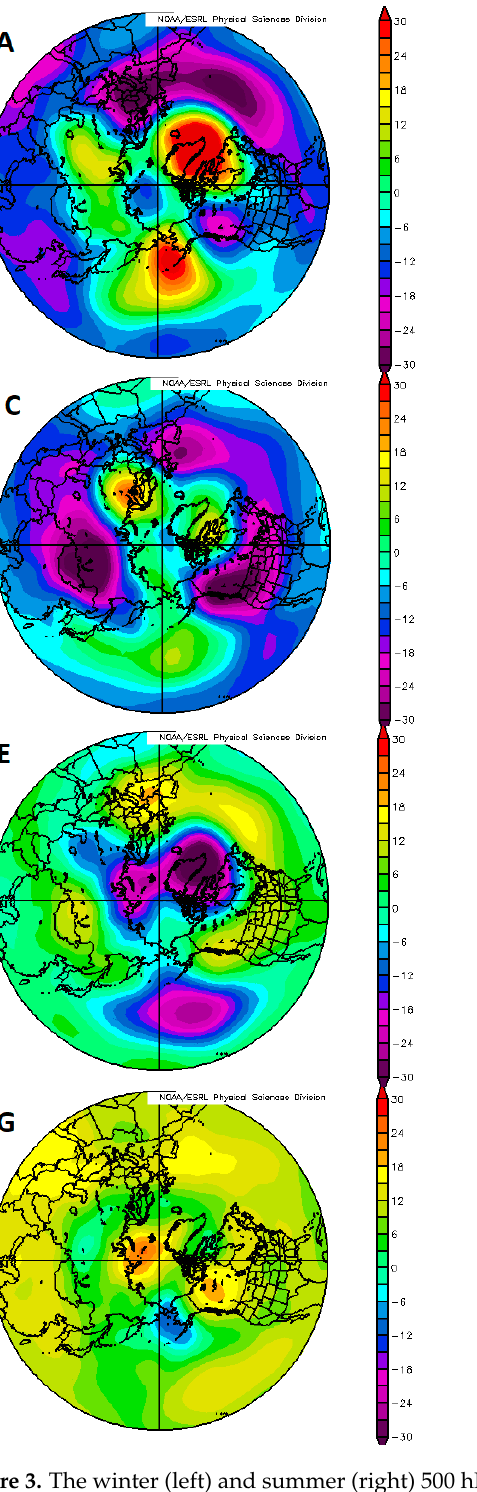
Figure 3. The winter (left) and summer (right) 500 hPa height anomalies (with respect to 1957–2017) for the sub-periods defined in Table 2, where ( A ) and ( B ) is 1957–1969, ( C ) and ( D ) 1970–1980, ( E ) and ( F ) 1981–1997, and ( G ) and ( H ) 1998–2017. The contour interval is 3 m.